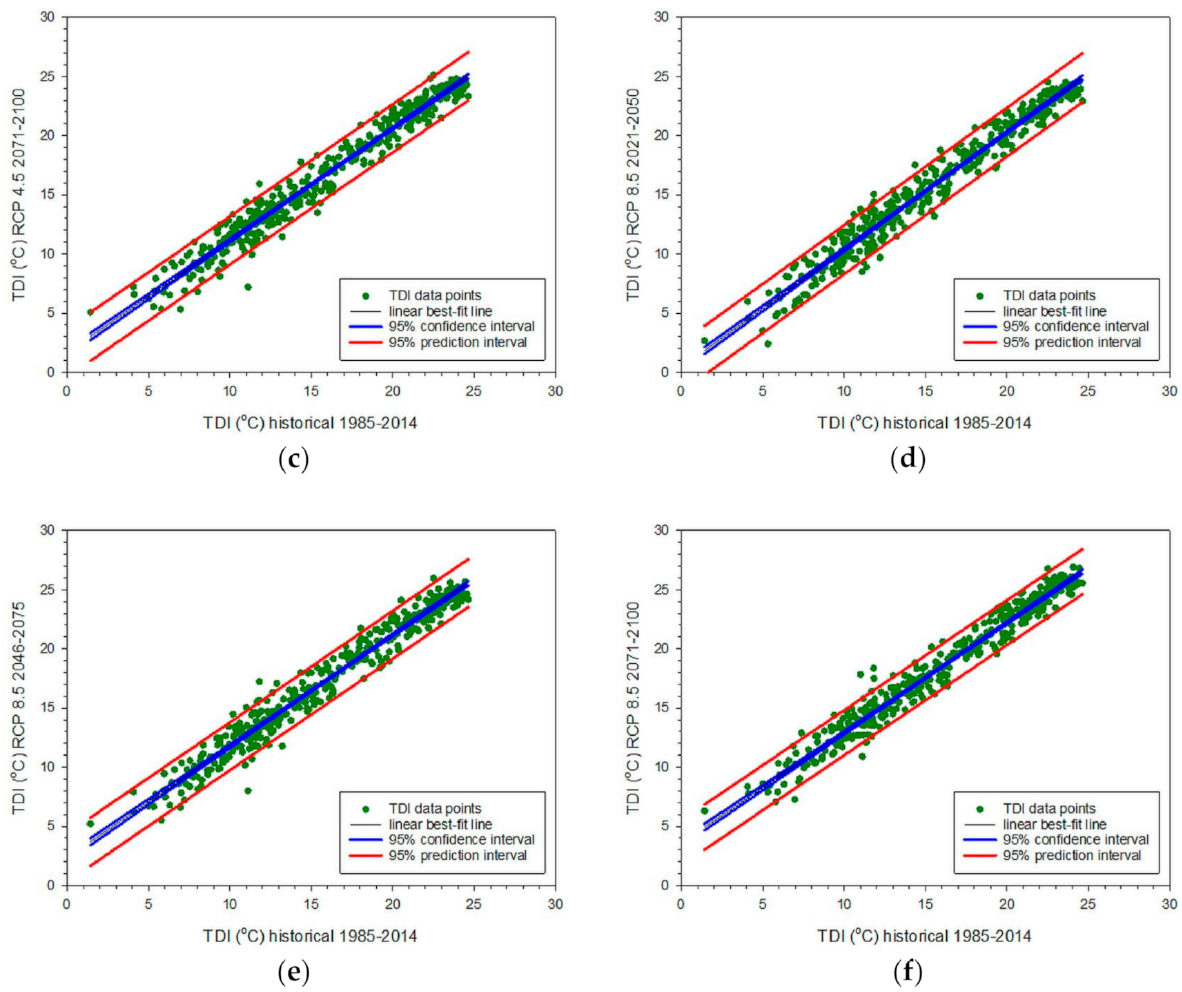
Figure 10. Scatter plots of the monthly mean TDI values averaged over all 33 sites; the x-axis has the TDI values in the historical period and the y-axis in the future epoch of ( a ) RCP 4.5 2021–2050, ( b ) RCP 4.5 2046–2075, ( c ) RCP 4.5 2071–2100, ( d ) RCP 8.5 2021–2050, ( e ) RCP 8.5 2046–2075, and ( f ) RCP 8.5 2071–2100. The solid black line is the best-fit to the data pairs. The 95% confidence and prediction intervals are also shown. R 2 has the following values: ( a ) 0.9635, ( b ) 0.9609, ( c ) 0.9600, ( d ) 0.9626, ( e ) 0.9601, and ( f )